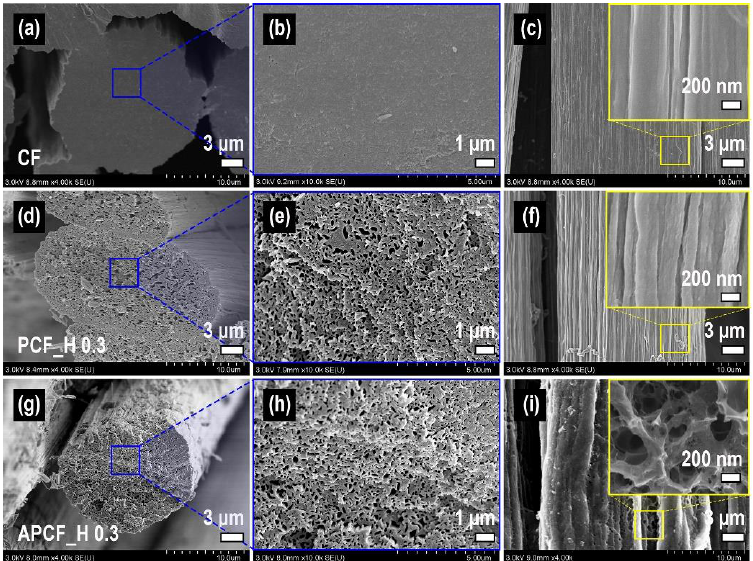
Figure 3. FE-SEM images of ( a – c ) carbon fiber prepared by carbonization of mono-component PAN, ( d – f ) PCF_H 0.3, and ( g – i ) APCF_H 0.3. ( a , d , g ) cross-section, ( b , e , h ) enlarged cross-section, ( c , f , i ) side view (inset: enlarged side view). Table 2. Surface area, microporosity, and hydrogen storage capacity of samples at 77 K and 10 MPa in comparison with reported literature.